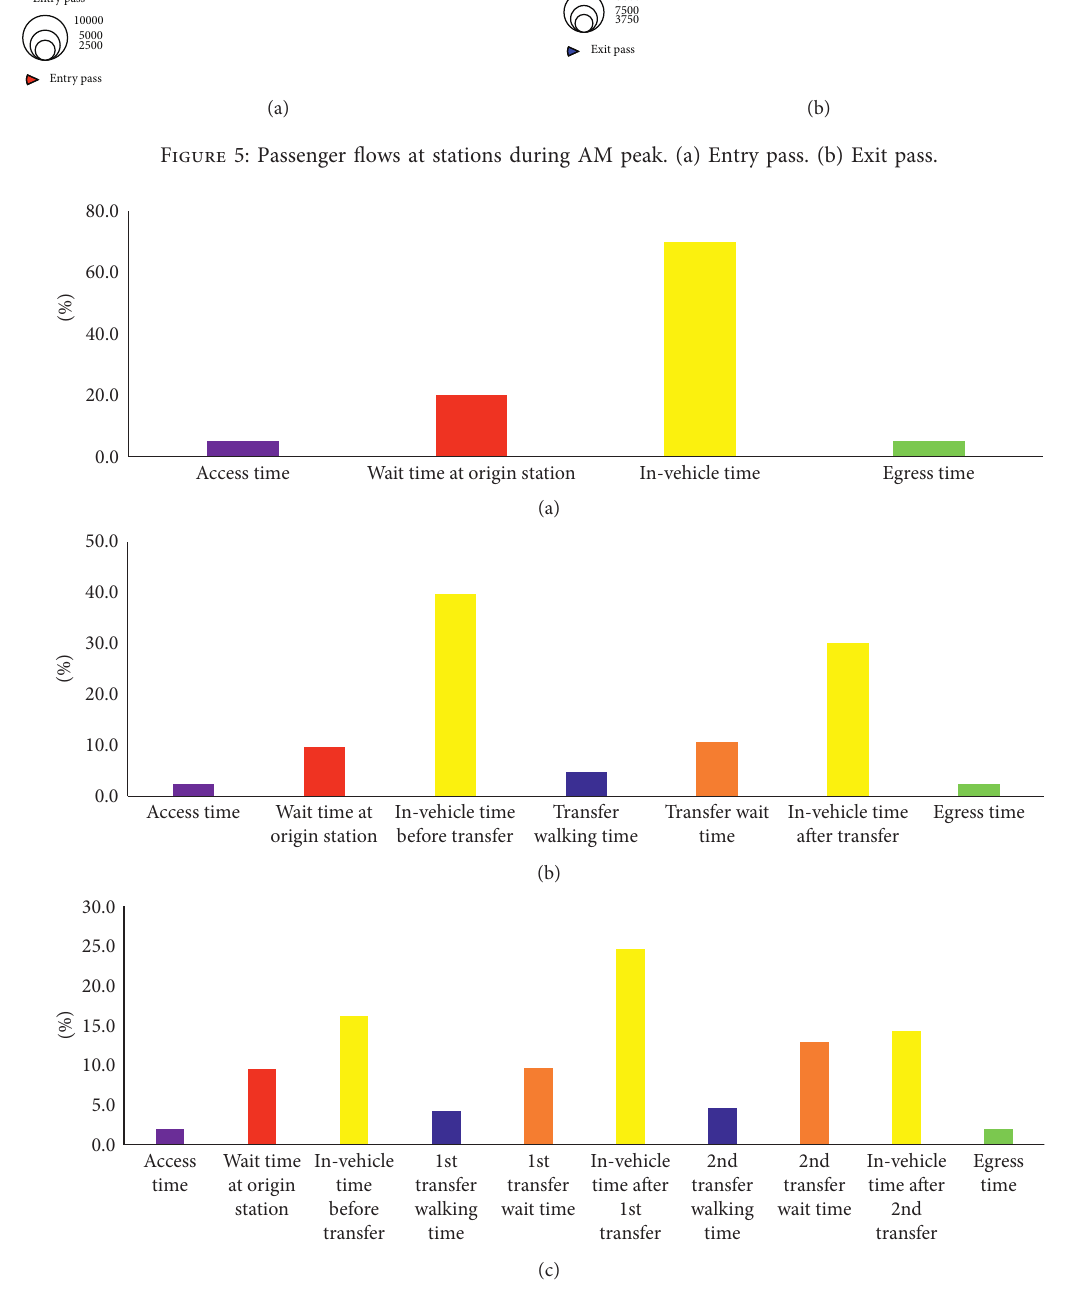
Figure 6: Travel time components for passengers. (a) Nontransfer passengers. (b) Passengers with one transfer. (c) Passengers with two